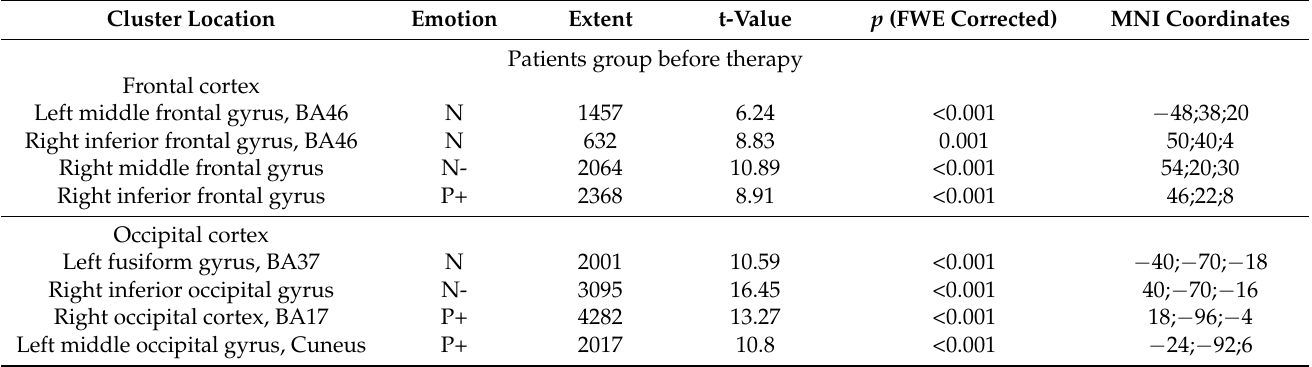
Table 2. Cluster and peak statistics for brain activations during facial emotion recognition in patients with depression.